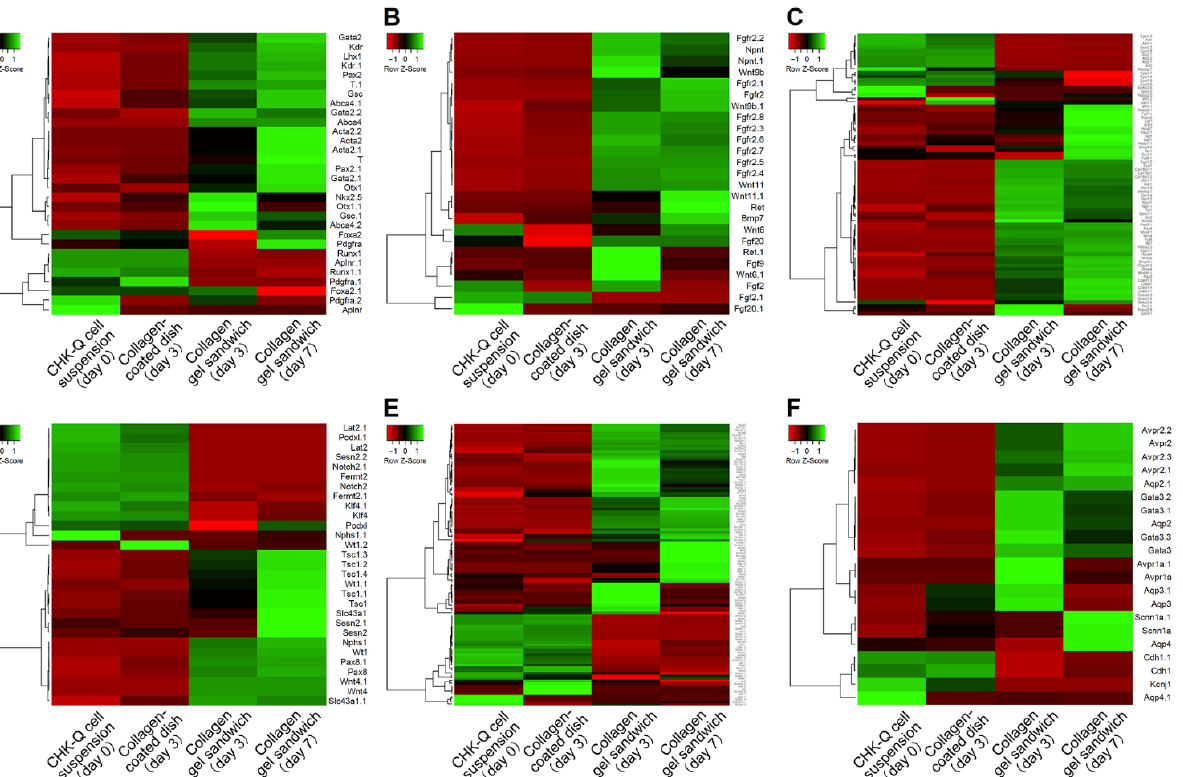
Figure 2. Gene expression heat map of ( A ) mesoderm, ( B ) ureteric bud, ( C ) nephron progenitor cells and metanephric mesenchyme, ( D ) renal corpuscle, ( E ) uriniferous tubule, and ( F ) collecting duct-related genes. Pearson’s correlation was selected as the distance metric; average linkage clustering was selected as the linkage method.